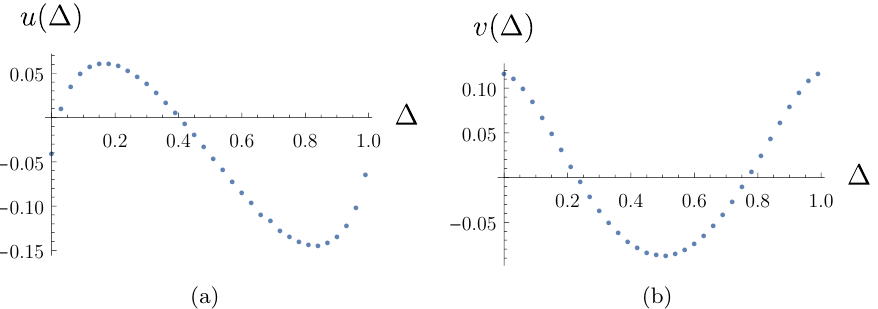
Figure 5 . The functions u ((cid:1)) and v ((cid:1)) computed numerically by the method described in ap- pendix